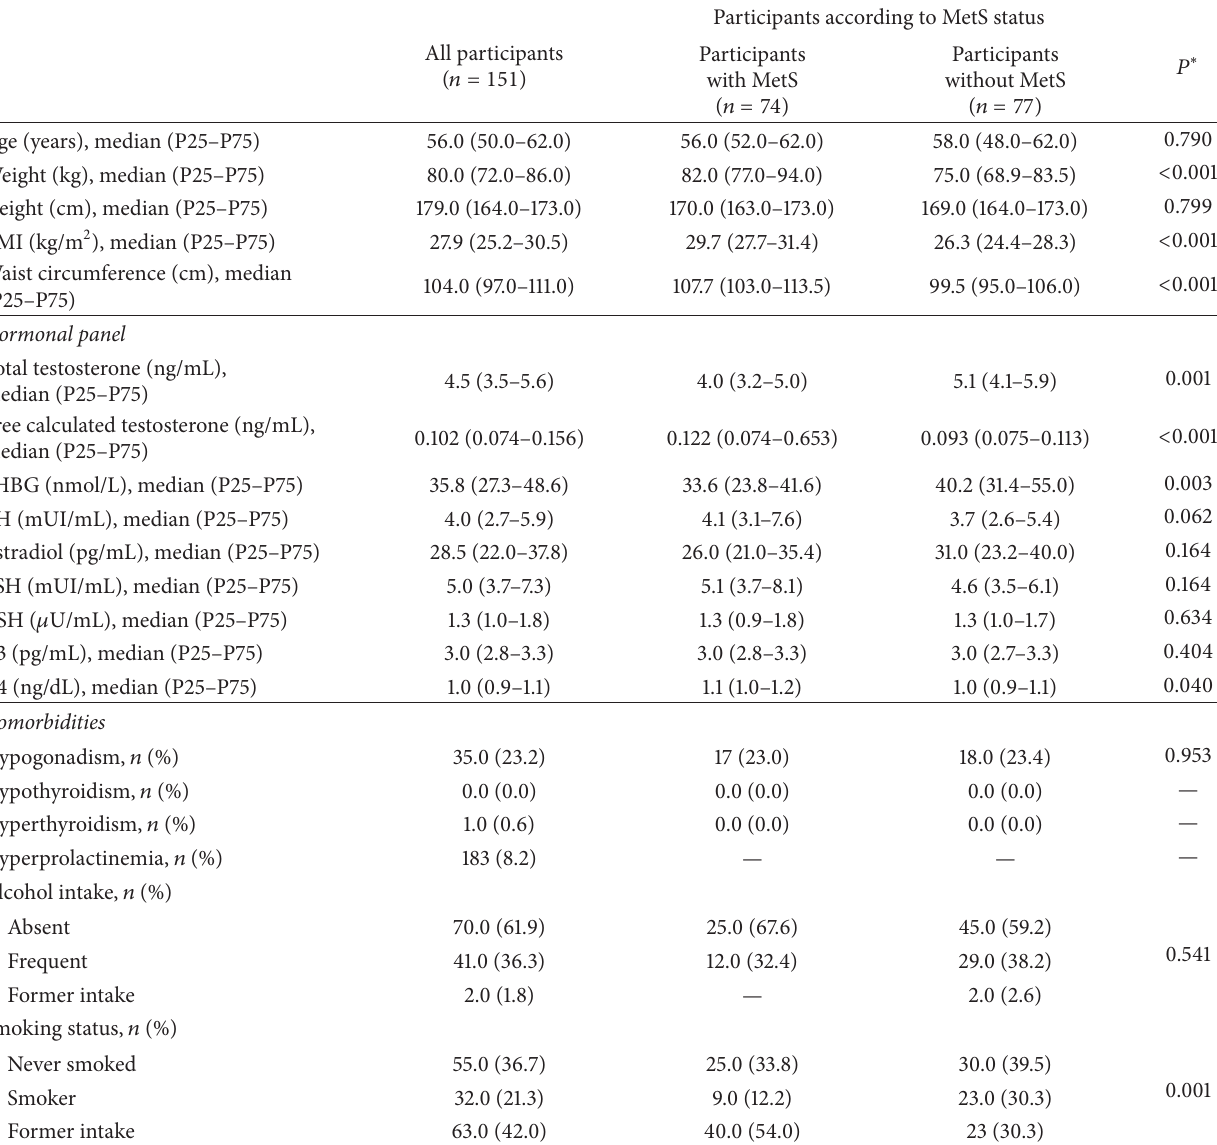
Table 1: Population